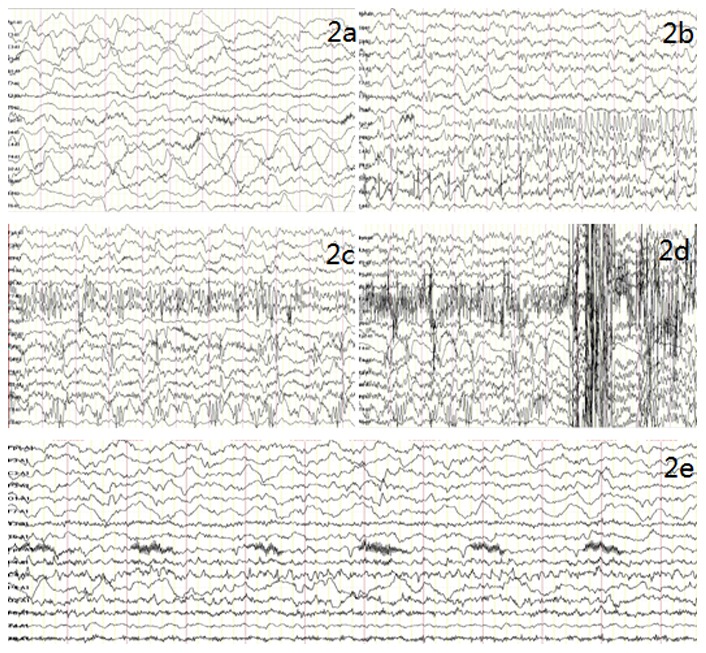
EEG recordings obtained after KA administration.The locations of the recording electrodes: Fp1, F3, C3,P3, 01 and F7 located in the left cortex zone; T3 located in the left hippocampus; T5 located in the left temporal lobe; FP2, F4, C4, P4, 02 and F8 located in the right cortex zone; T4 located in the right hippocampus; T6 located in the right temporal lobe. a: Dominated by slow waves and low amplitude fast waves; b: The right hippocampus first demonstrated spikes discharges that then were transmitted to the right cortex, followed by explosive spike rhythms in the right cortex; c: The left hippocampus demonstrates spike wave rhythms; d: Spine wave rhythms are shown; e: EEG after attack, dominated by slow waves and low amplitude fast waves.